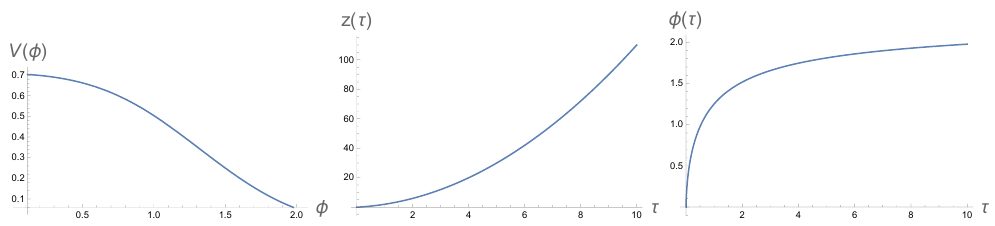
Figure 3 . The profile of V ( φ ) (left), z ( τ ) (middle) and φ ( τ ) (right) for α = λ = 1 . We find φ ∗ ' 2 . 5 .